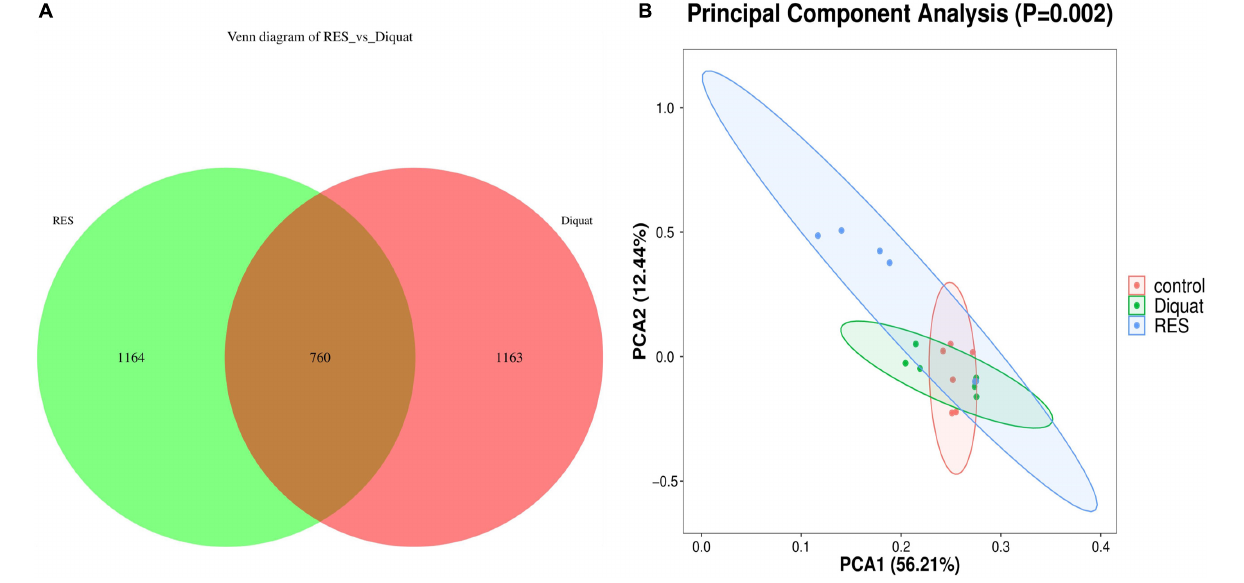
FIGURE 1 | Gut microbiome diversity analysis. (A) Venn diagram shows the unique and shared OTUs in the RES and diquat groups ( n = 6). (B) Principal component analysis (PCA) of bacterial community structures in different groups; each represented by one color ( n = 6). RES, colonic microbiota of the supplementation resveratrol group; diquat, colonic microbiota of the diquat-challenged group. The same as